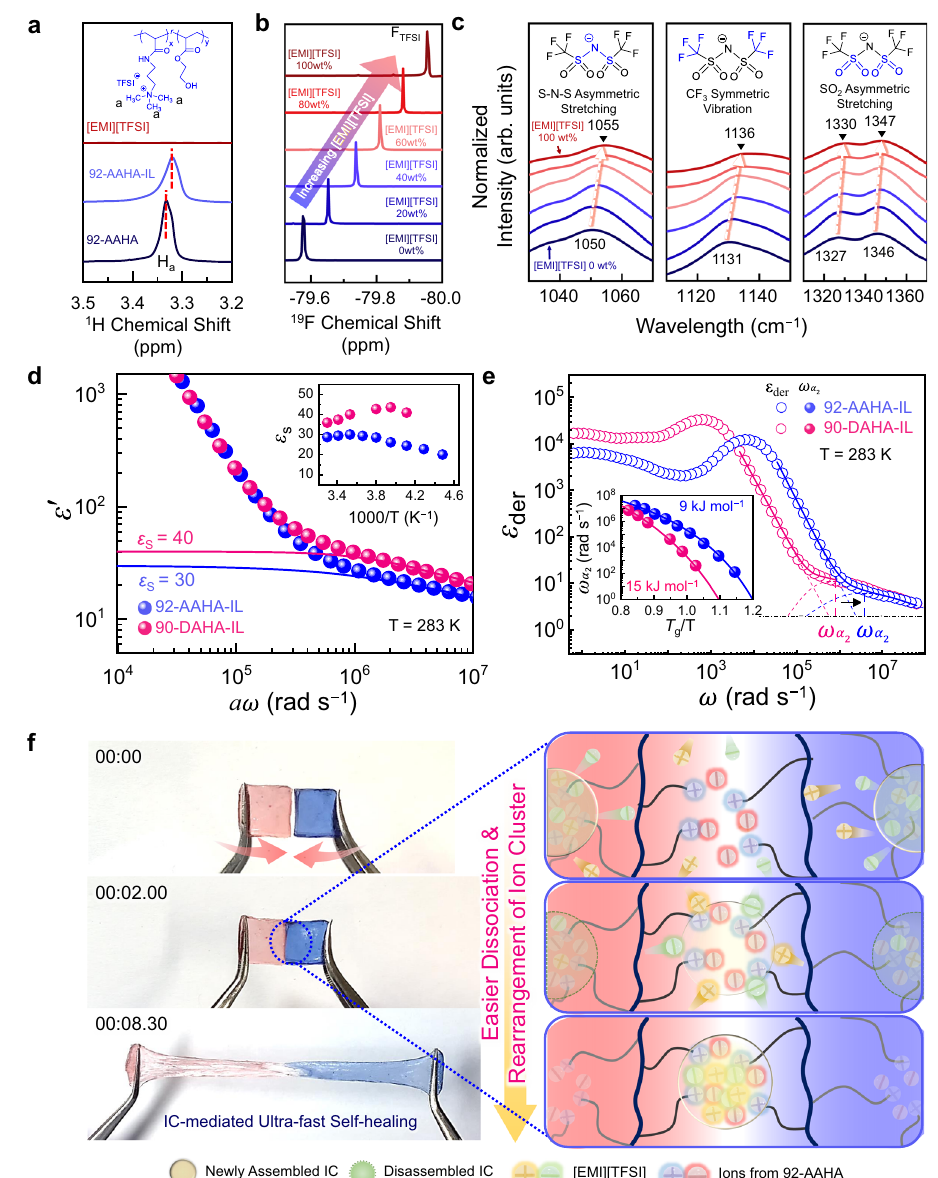
Fig. 2 Spectroscopic analysis of ion cluster formation for ultra-fast self-healing. a Comparison of 1 H NMR spectra for 92-AAHA, 92-AAHA-IL, and [EMI] [TFSI], in which 92-AAHA-IL contained 30 wt% [EMI][TFSI]. Changes in b 19 F NMR spectra and c FTIR absorption peaks related to [TFSI] – contained in 92-AAHA-IL. The contents of [EMI][TFSI] were 0 (navy line, neat 92-AAHA), 20, 40, 60, 80, and 100 wt% (red line, neat [EMI][TFSI]). d Dielectric permittivity spectra ( ε ′ ) shifted by horizontal shift factor ( a ) ( a = 1 for 92-AAHA-IL, a = 3.4 for 90-DAHA-IL). Blue and red solid lines represent the static dielectric constant ( ε s ) of 92-AAHA-IL and 90-DAHA-IL, respectively. The inset shows ε s variations as a function of temperature. e Frequency dependence of derivative ε der spectra of 92-AAHA-IL and 90-DAHA-IL at 283 K. The inset shows the temperature-dependent α 2 relaxation frequency with the Vogel- Fulcher-Tammann (VFT) fi tting. f Schematic illustration of the self-healing mechanism of 92-AAHA-IL, based on the rapid dissociation and re-assembly of ion clusters